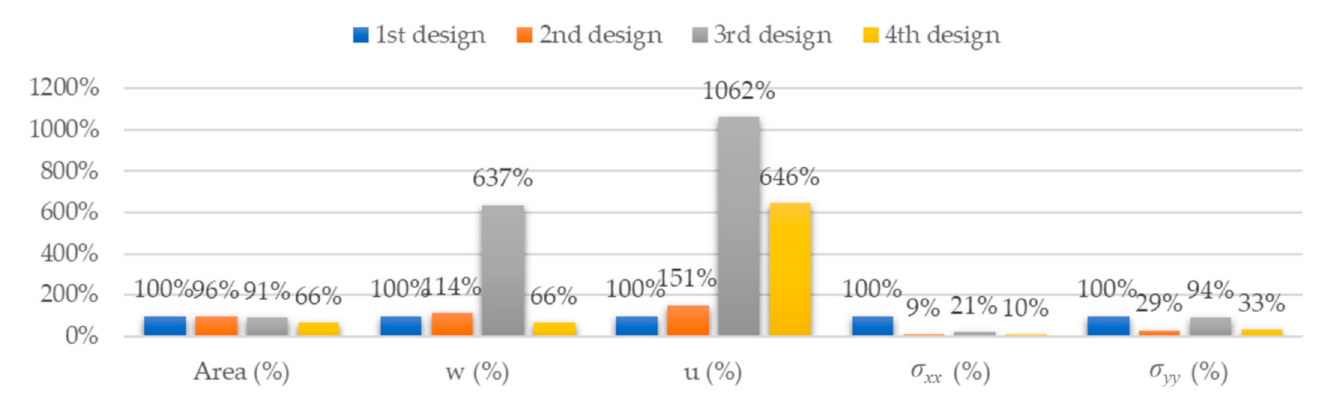
Figure 31. Comparative results for the best configurations found for each